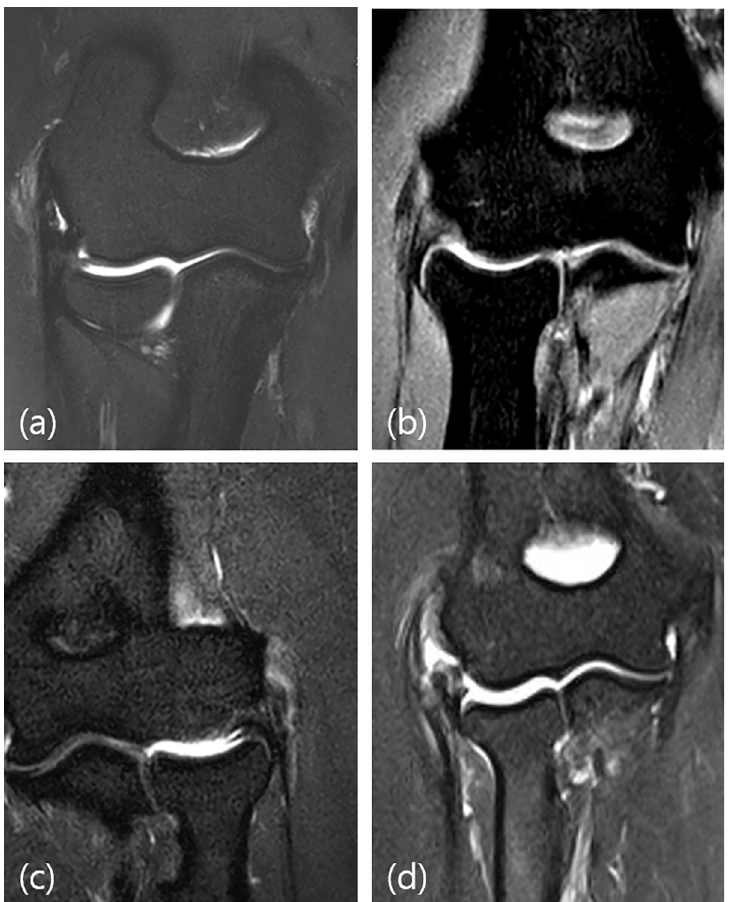
Fig 1. a. 41-year-old woman with tendinosis of the common extensor tendon (CET). b. 59-year-old man with intermediate-grade partial tear of the CET and partial tear of the lateral collateral ligament complex (LCLC). c. 48-year-old woman with high-grade partial tear of the CET and partial tear of the LCLC. d. 54-year-old woman with near-complete tear of the CET and LCLC.